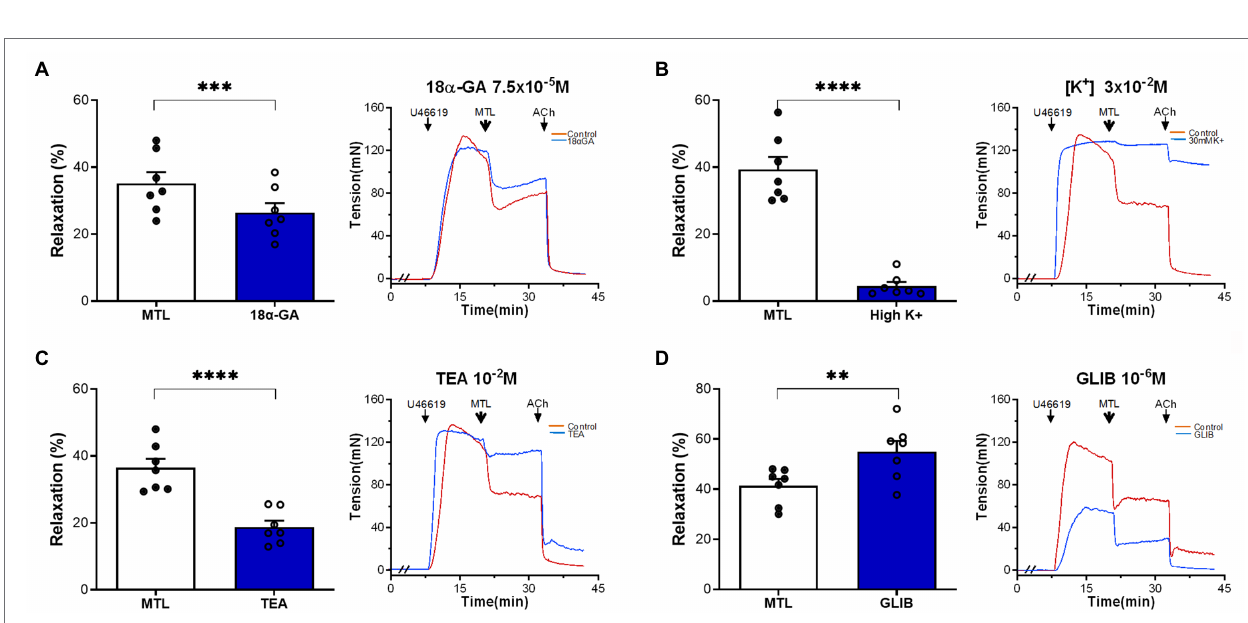
FIGURE 8 | Role of PGI 2 on motilin-induced vasorelaxation. Effect of indomethacin (10 − 5 M) on LGA relaxation induced by motilin (9 × 10 − 8 M) and corresponding representative trace. Values are means ± SEM ( n = 7). ** p < 0.01 by paired t -test. The double slash (//) indicates pretreatment with indomethacin before incubation with U46619. The arrows indicate the time of drug administration. INDO, indomethacin; LGA, left gastric artery; MTL, motilin; PGI 2 , prostacyclin; SEM, standard error of the mean; and U46619, thromboxane A 2 receptor